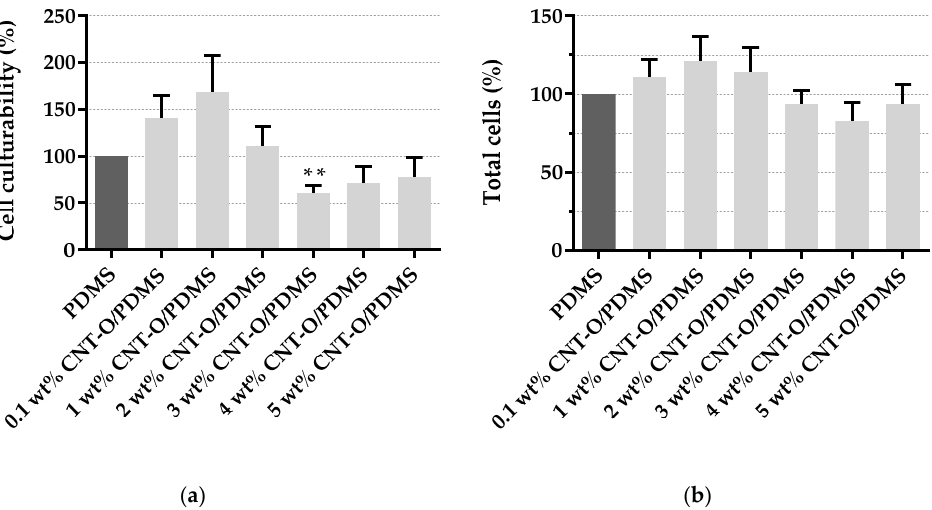
Figure 4. Percentage of E. coli CECT 434 GFP ( a ) culturable and ( b ) total cells after 24 h of biofilm formation on PDMS (control) and CNT/PDMS composite surfaces with different CNT-O loading (ranging from 0.1 to 5 wt%). The means ± standard error (SE) for three independent experiments are illustrated. Significant differences were considered for p -values < 0.05 (** p <